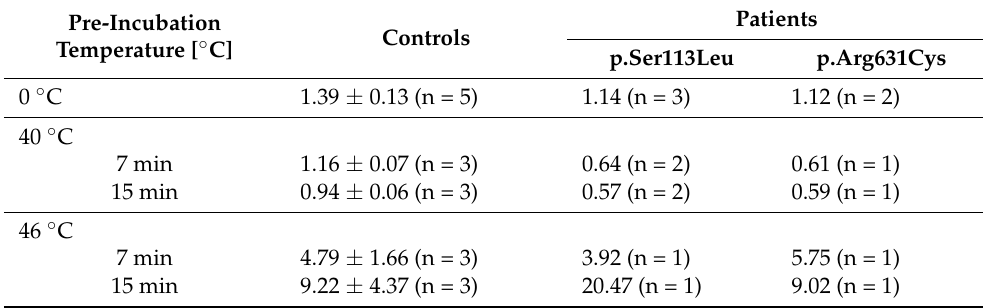
Table 2. Effect of cardiolipin (CLP) (0.25 mM) on CPT II activities in muscle homogenates of controls and patients with the p.Ser113Leu and p.Arg631Cys variants. Values are expressed as the ratio of the activity with over without pre-incubation with CLP for 7 and 15 min at 40 °C and 46 °C. The number of patients are given in parentheses. The data of controls are shown as mean (±SD) and the data of patients are shown as means wherever applicable.